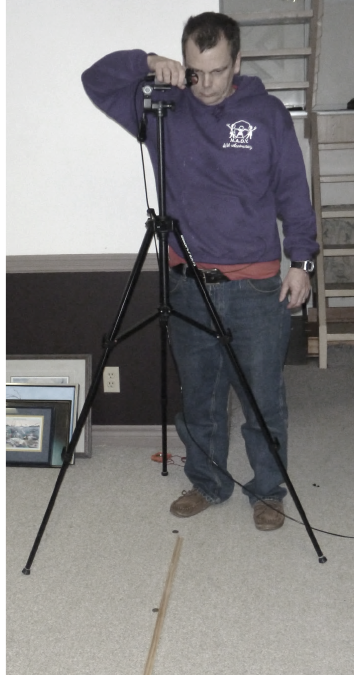
Figure 7. Geometer “sighting in”, by making declination measurements from a known Geometer height on target coins at a known distance from the